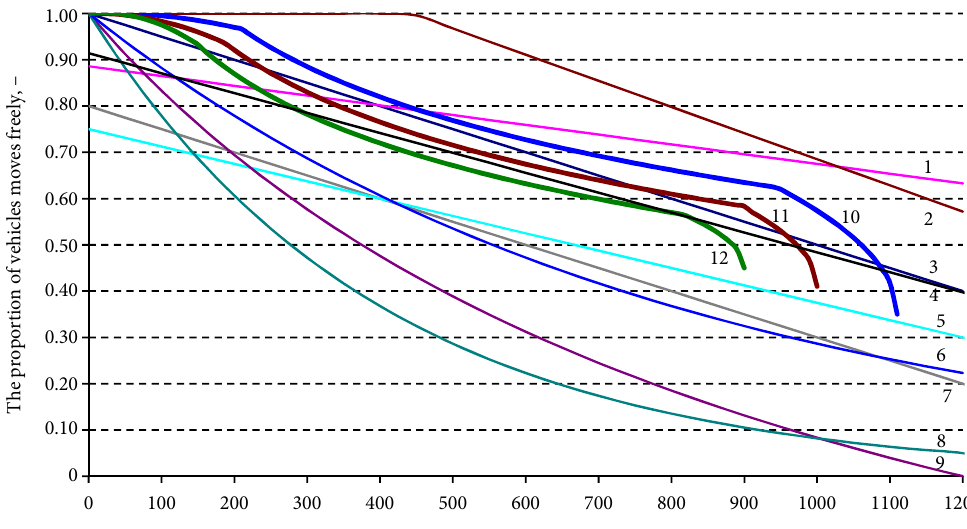
Traffic flow volume on the roadway around central island of small roundabout ( Q ), Fig. 4. Function of the proportion of vehicles which move freely depending of traffic flow according to different models, where 1 – O. Hagring’s model (Eq (7)); 2 – S. Tanyel’s & N. Yayl’s model (Eq (12)); 3 – J. Tanner’s model (Eq (6)); 4 – O. Hagring’s model (Eq (8)); 5 – R. Akçelik’s model (Eq (10)); 6 – R. Akçelik’s model (Eq (14)); 7 – R. Troutbeck’s model (Eq (9)); 8 – W. Brilon’s model